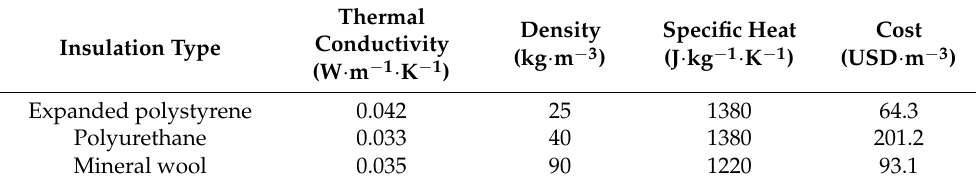
Table 2. Characteristic parameters of thermal insulation [15,18].